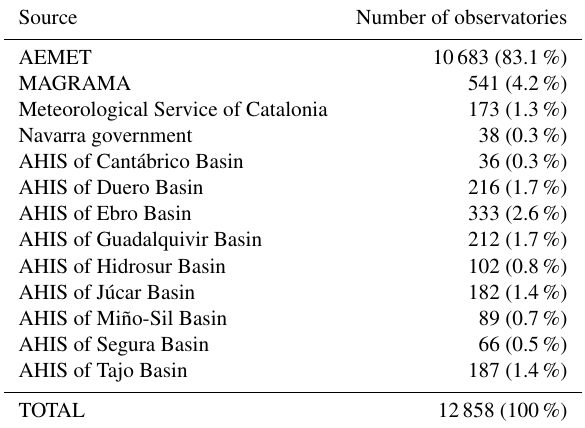
Table 1. Number of observatories, by source (AEMET: Spanish meteorological agency; MAGRAMA: Ministry of Agriculture and Environment; AHIS: Automatic Hydrological Information System). Source Number of